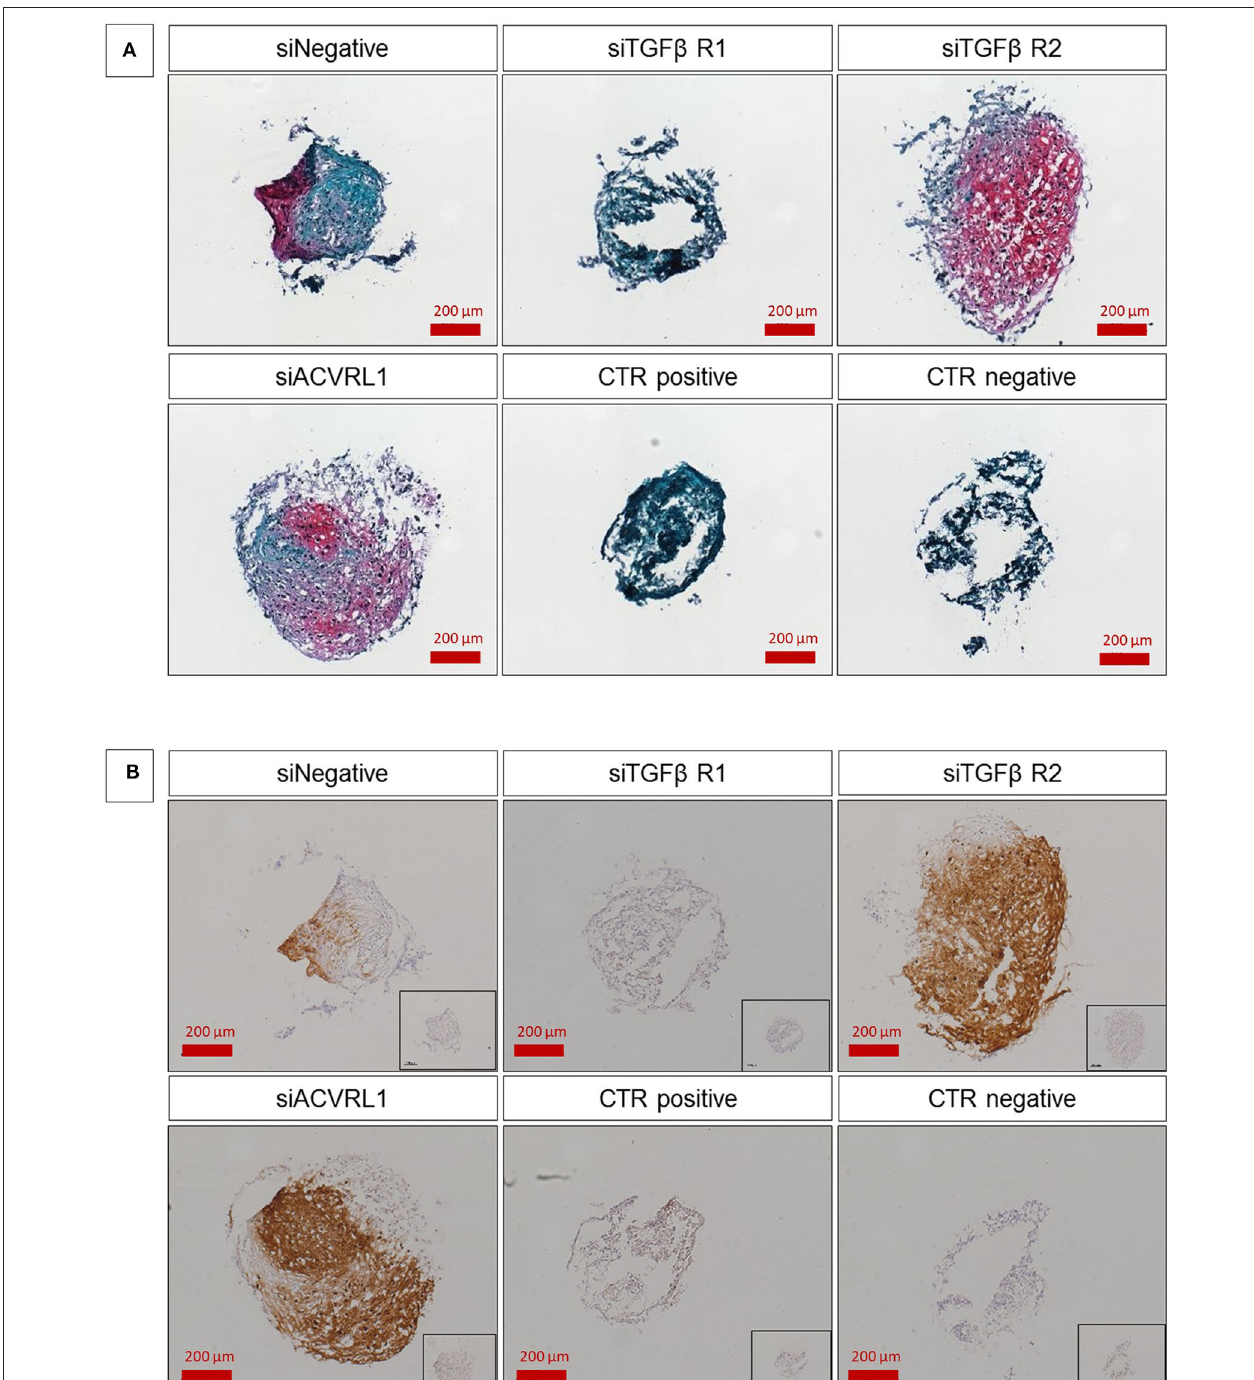
FIGURE 7 | Safranin-O/fast green staining (A) and type II collagen/hematoxylin-mayer immunostaining (B) of hMSC pellets. SiNegative shows pellet that has been transfected with scramble control and was cultured with TGF β ; siTGF β R1, siTGF β R2, and siACVRL1 were transfected with the respective siRNA and was cultured with TGF β ; CTR positive has been not transfected but was cultured with TGF β ; CTR negative has been not transfected and was not cultured with TGF β . The intensity of safranin-O (Red) staining is directly proportional to the proteoglycan content inside the pellet, while green structures represent the counterstaining with fast green solution (A) . Brown color represents the positive reaction to type II collagen, counter stained with Hematoxylin-Mayer; Inset images show the respective negative controls for the immunostaining (B) . The figures are representative of five separate experiments using five different donors. Scale bar for 10 × objective = 200 µ m.